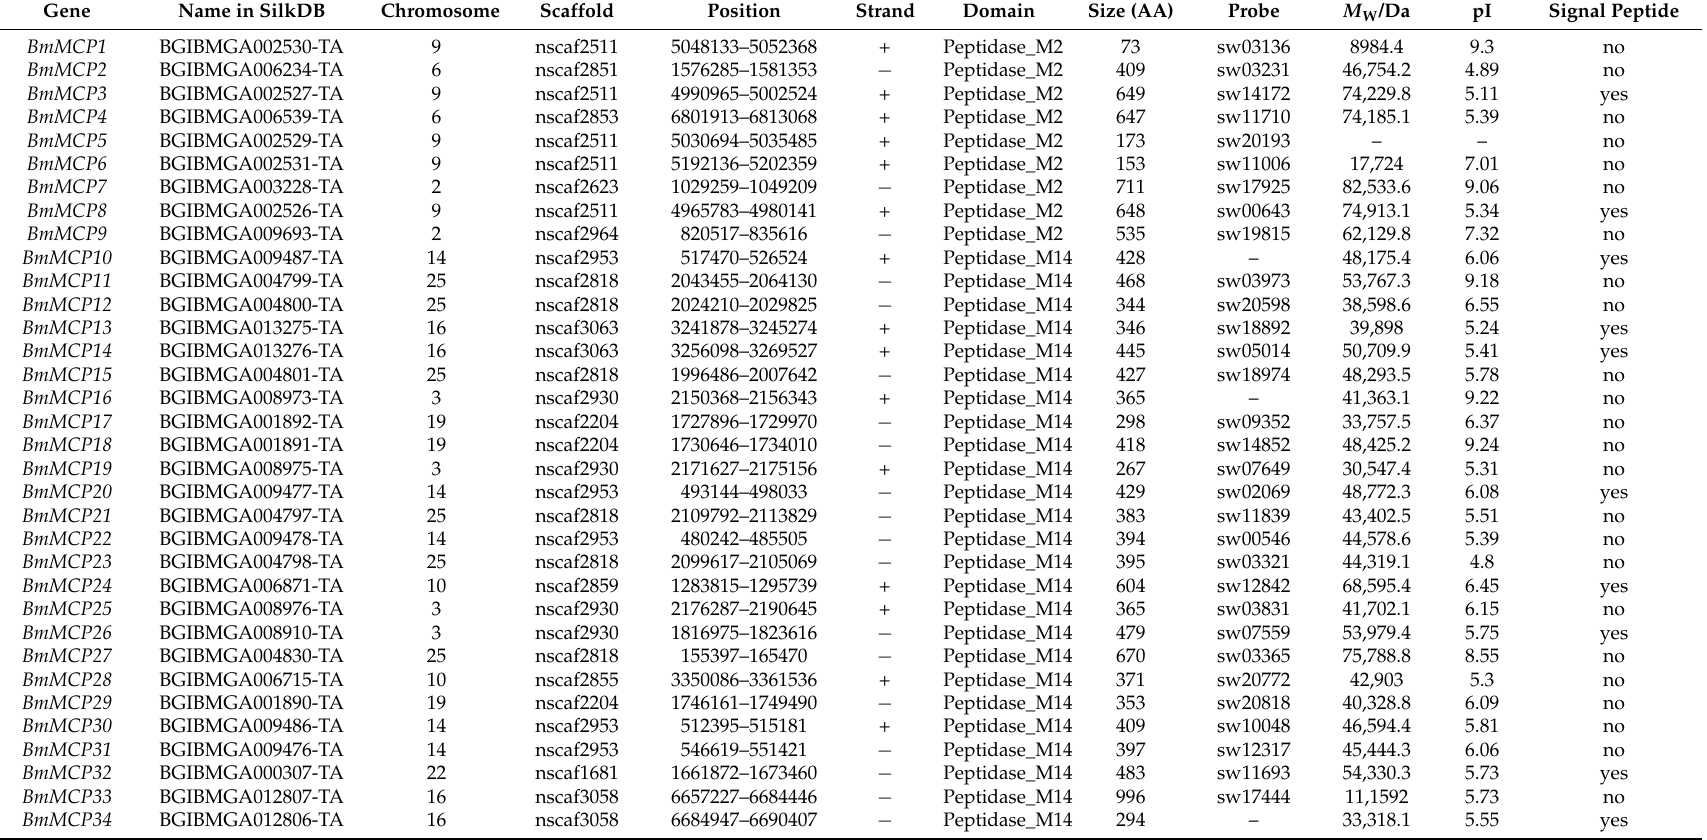
Table 1. Characterization of silkworm